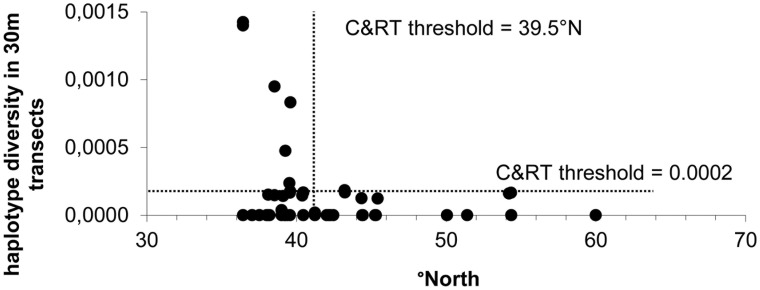
Within population diversity along latitudinal gradient.Haplotype diversity in 72 populations (30 m transects) plotted against latitudes (°N) with indication of threshold values obtained from a Classification and Regression Tree analysis. Highest within population diversity resides in regions <40°N. Note the large number of monomorph sites across all latitudes.